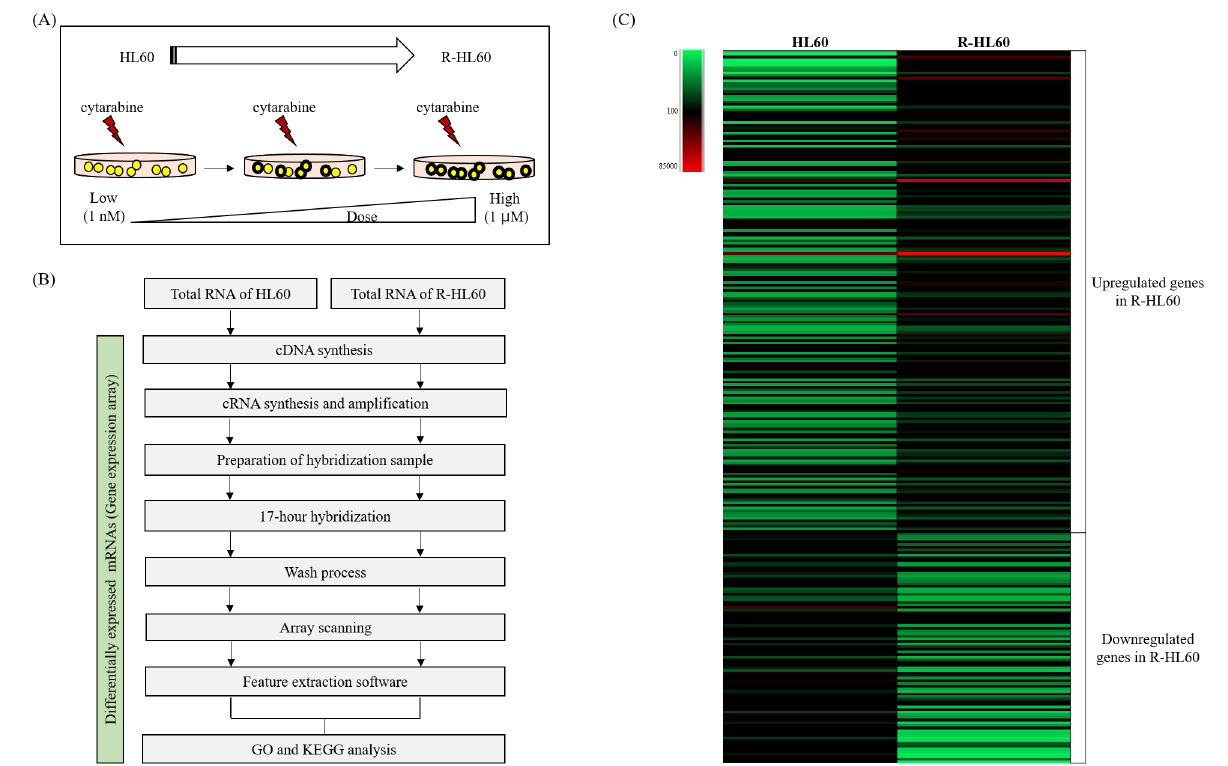
Figure 1. Results of the gene expression array procedures. ( A ) The R-HL60 cell line was established through continual treatment of parental HL60 cells with increasing concentrations of cytarabine. ( B ) The experimental flow chart of the gene expression array. ( C ) Heat map depicting the hierarchical clustering of changed differentially expressed genes (DEGs) between HL60 and R-HL60 cells. In the clustering analysis, upregulated and downregulated genes are colored in red and green,